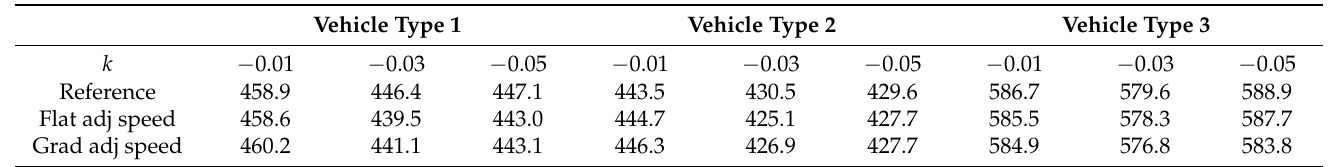
Table 9. Total energy consumption (Wh) under alternative speed profiles, gradient assumptions, and vehicle types (symmetric valley, WMTC Reference Cycle 2).